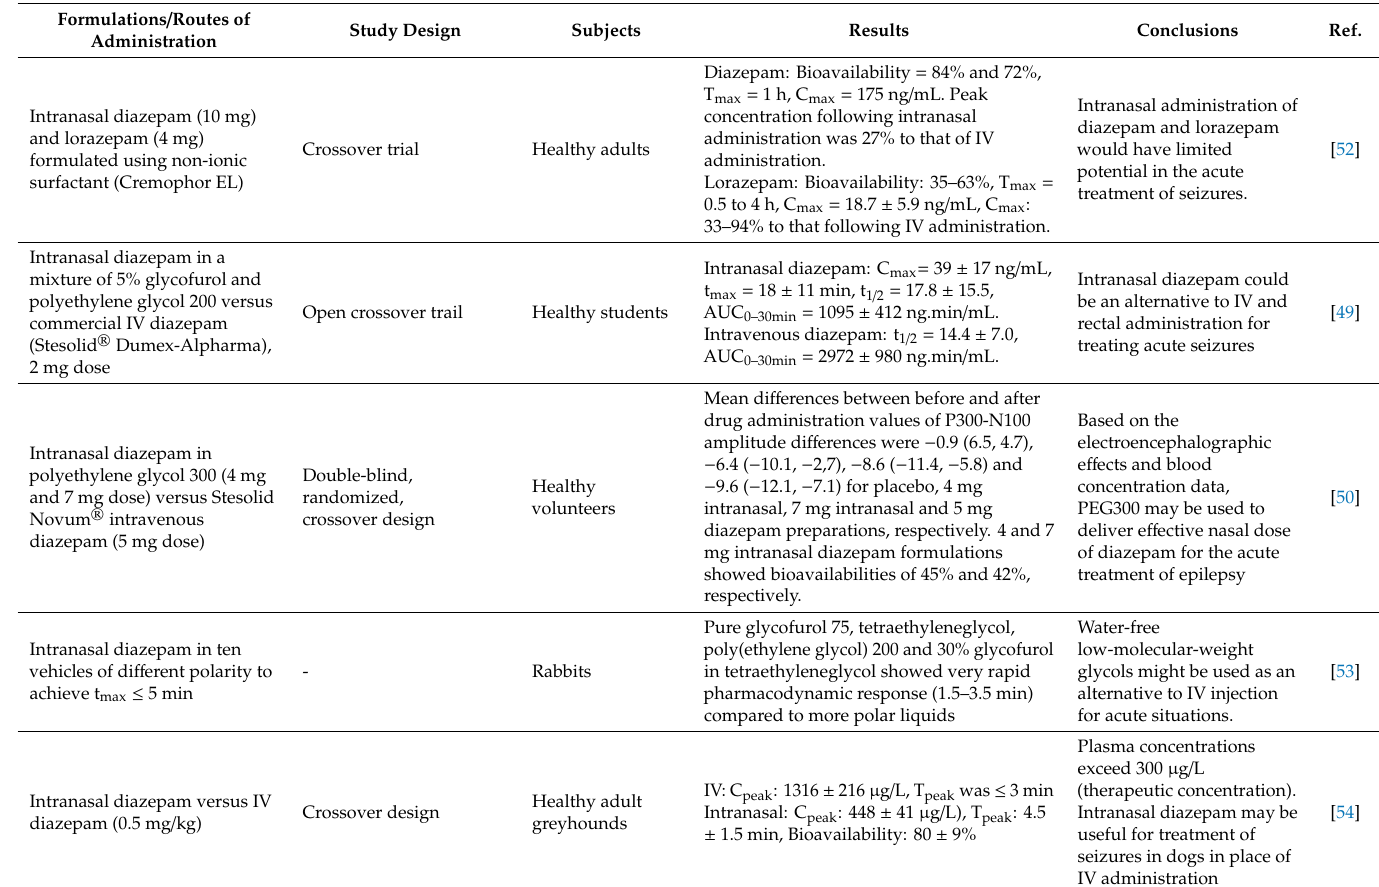
Table 4. Preclinical and clinical pharmacokinetic studies related to the use of intranasal